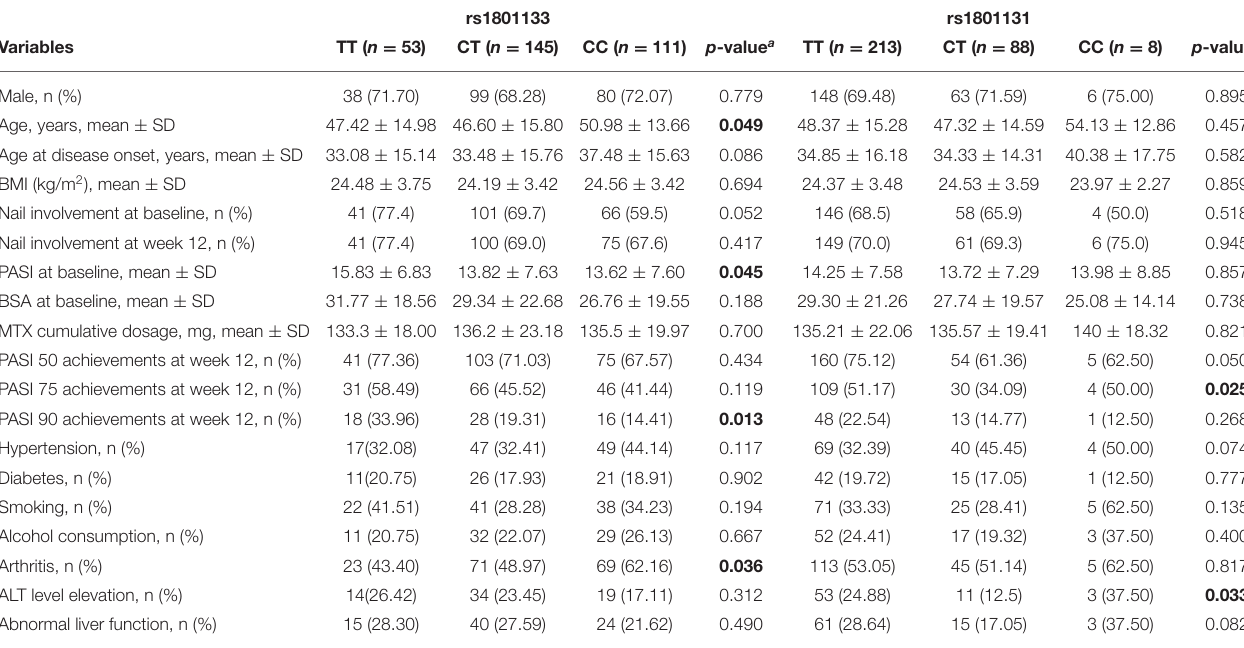
TABLE 1 | Clinical characteristics of 309 patients with psoriasis according to rs1801133 genotype and rs1801131 genotype. rs1801133 rs1801131